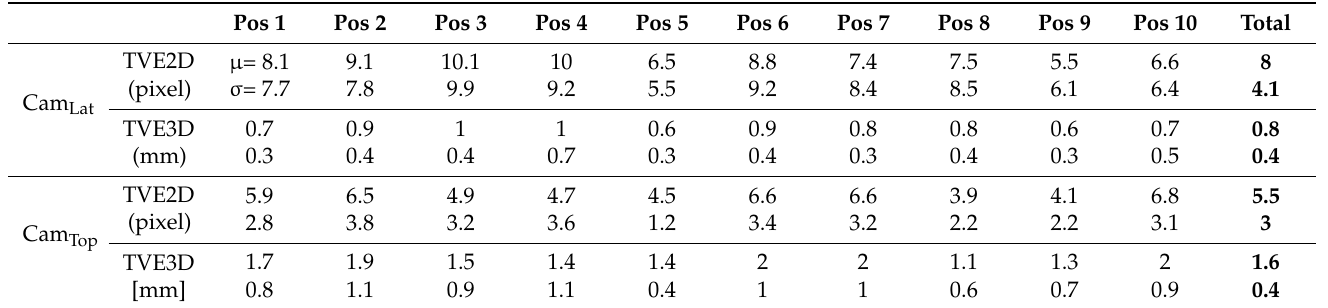
Table 1. Mean ( µ ) and standard deviation ( σ ) of target visualization errors (TVE)2D and TVE3D values for each of the 10